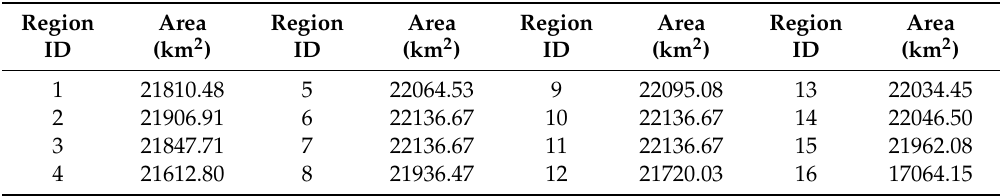
Table 5. Area of each